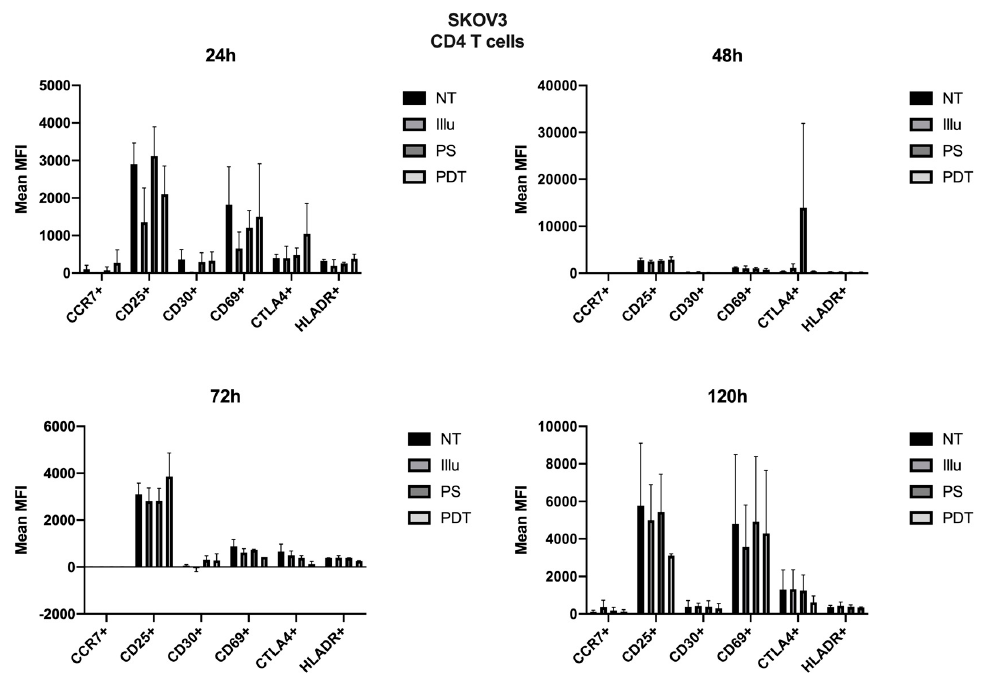
Figure 8. FACS analysis of activating markers of CD8+T cells cultured with conditioned media of OVCAR3 cells at 24 h, 48 h, 72 h, and 120 h. NT: non-treated, PS: Photosensitizer only, illu: illumination only, PDT: illumination in the presence of PS, ML10: the raw culture media of PBMC. Results are expressed in Mean of MFI ( n = 3 independent donors).